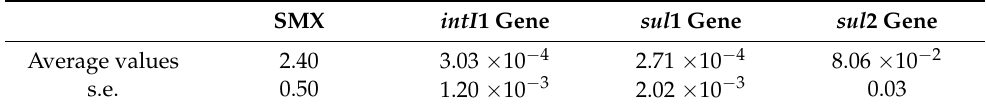
Table 1. Average SMX concentration ( µ g/kg), SMX-ARGs ( sul 1 and sul 2), and intI 1 gene relative abundances measured in the digestate. s.e.: standard error.